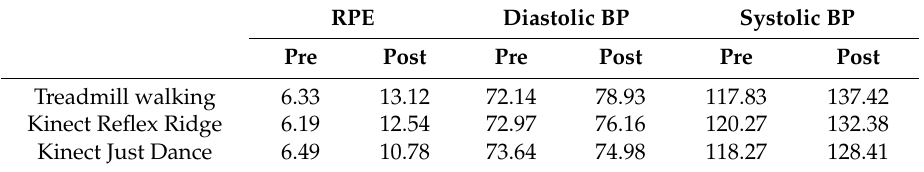
Table 1. Pre-/post- RPE and blood pressure (BP) scores in a counterbalanced study design. RPE Diastolic BP Systolic BP Pre Post Pre Post Pre Post Treadmill walking 6.33